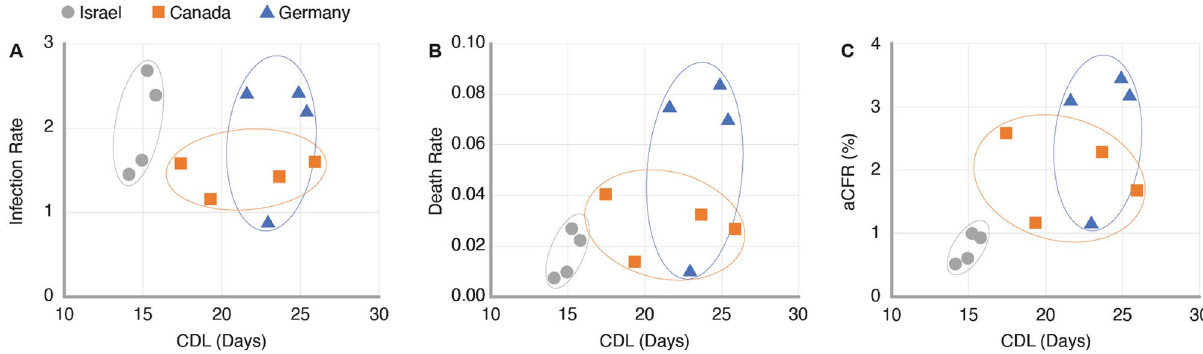
Figure 4. CDL compared to modelled infection rates ( A ), death rates ( B ), and aCFRs ( C ), in Israel, Canada, and Germany during the second wave of the COVID-19